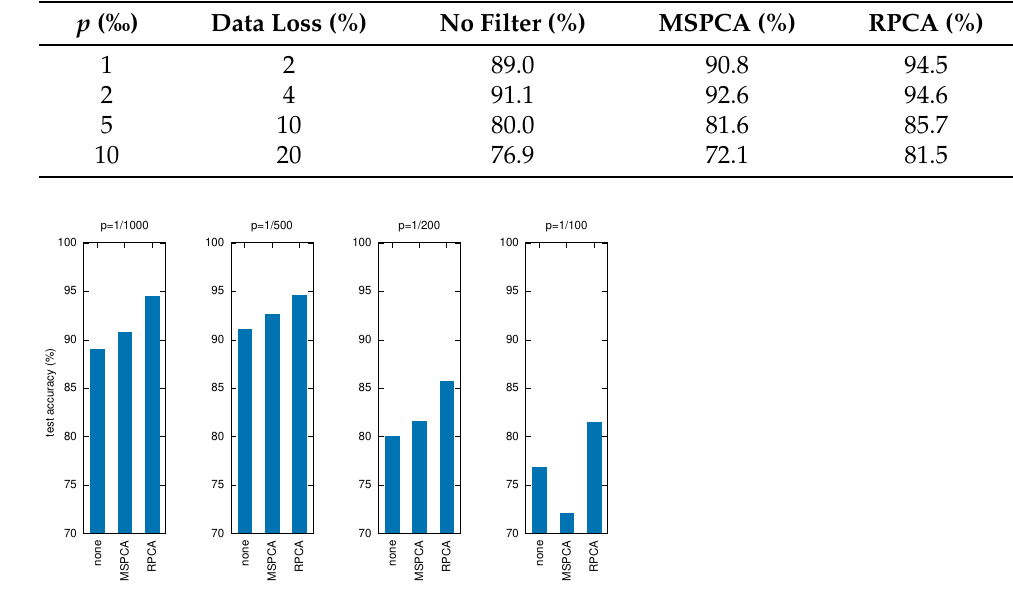
Figure 10. Test accuracy for corrupted signals with different filtering techniques ( p is the corrup- tion